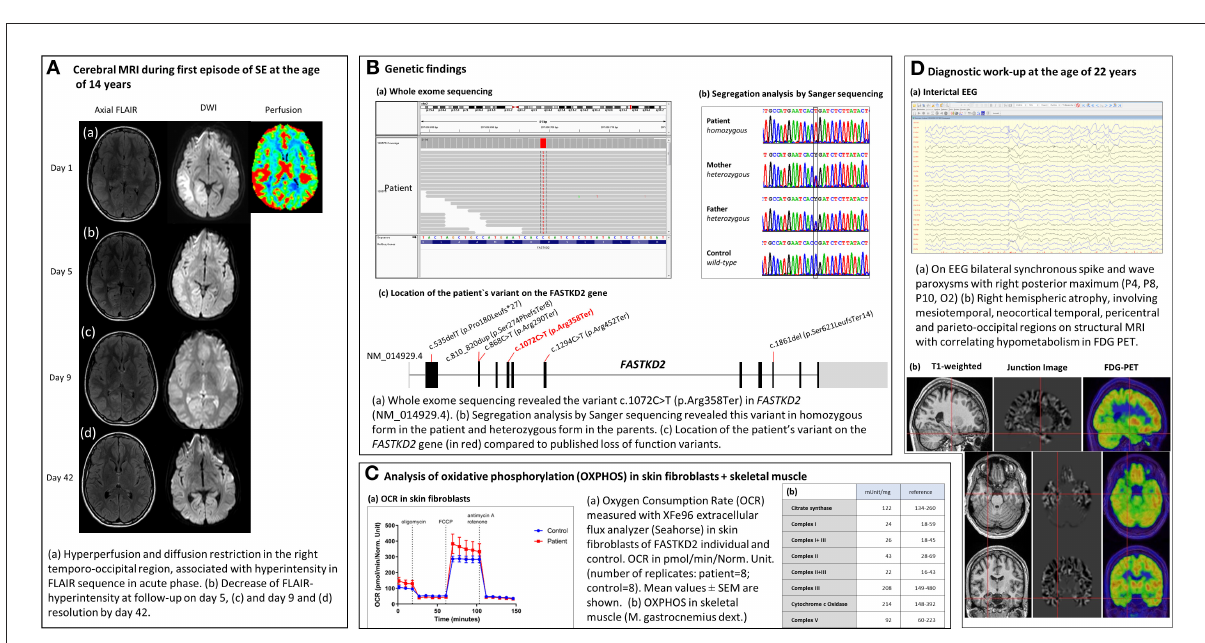
FIGURE2 Timeline: Clinical course of a patient with FASTKD2 related mitochondrial disease.